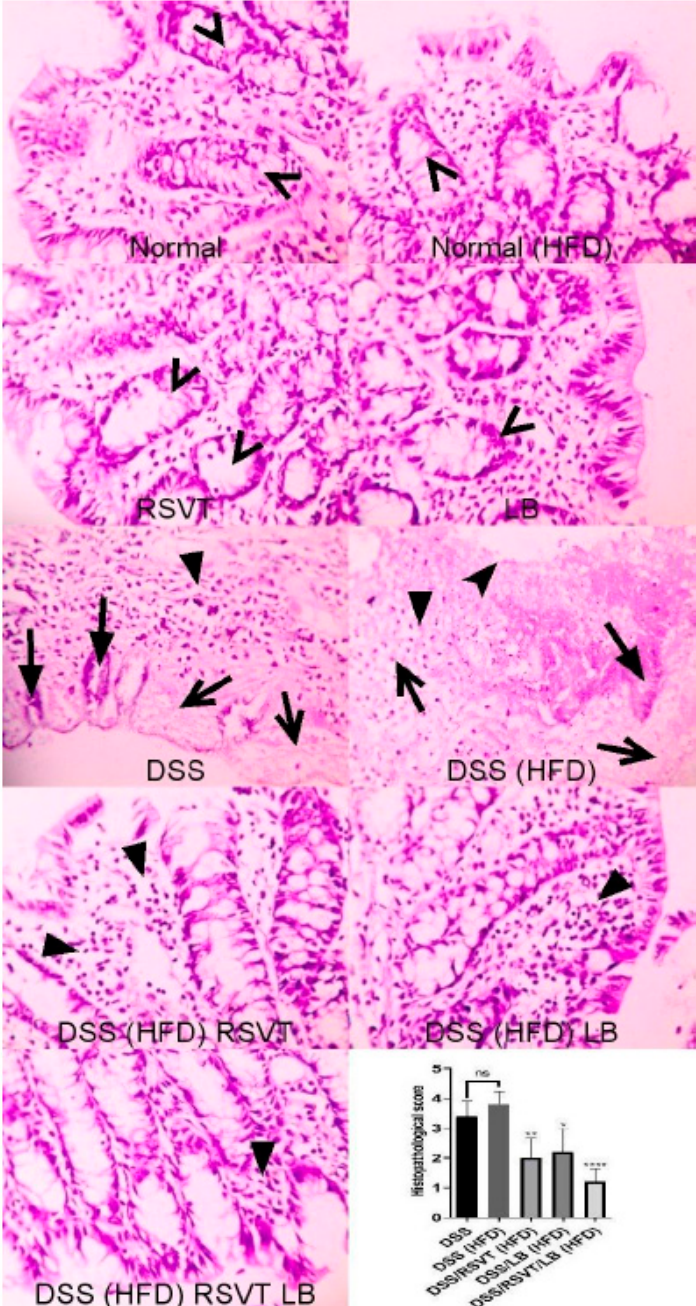
Figure 2. Photomicrographs of colon specimens from Normal, Normal (HFD), RSVT, and LB rat groups displaying normal colonic mucosa and crypts (open arrowheads). Colon specimens from DSS and DSS (HFD) rat groups display de-epithelialization (notched arrowhead), loss of crypts (filled arrows), degenerated tissue (open arrows) and inflammatory cell infiltration (filled arrowhead). Colon specimens from DSS/RSVT (HFD) and DSS/LB (HFD) display moderate crypt degeneration and inflammatory cell infiltration (filled arrowhead). Colon specimens from DSS/RSVT/LB (HFD) display marked decrease in crypt degeneration and inflammatory cell infiltration (filled arrowhead). In addition, DSS/RSVT (HFD), DSS/LB (HFD) and DSS/RSVT/LB (HFD) groups of rats showed a significant decrease in the microscopic evaluation score ( p < 0.01, p < 0.05, p < 0.0001, respectively) compared with DSS (HFD) rats. H&E, × 400. *, p < 0.05 vs. DSS (HFD); **, p < 0.01 vs. DSS (HFD); ****, p < 0.0001 vs DSS (HFD); ns, non-significant.